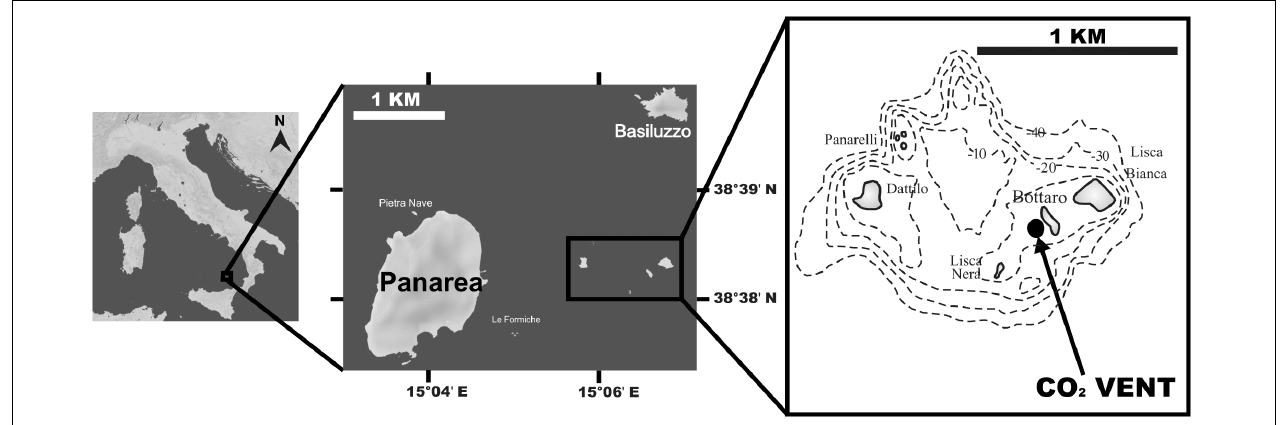
FIGURE 1 | Map of the study site off Panarea Island (Aeolian Archipelago, Italy); insets show the location of the vent area, SE of Bottaro, where corals were collected. Maps were generated using d-maps